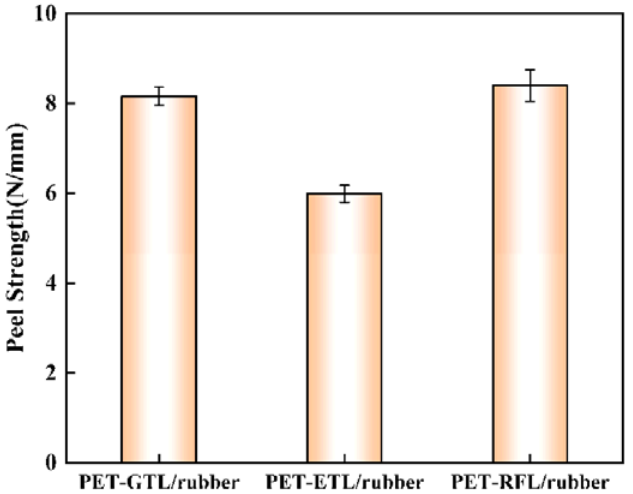
Figure 6. Peeling strength of PET-GTL/rubber, PET-ETL/rubber and PET-RFL/rubber composites.